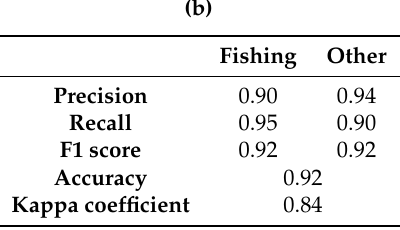
Table 5. Accuracy assessment using balanced test sets (equal numbers of fishing and non-fishing